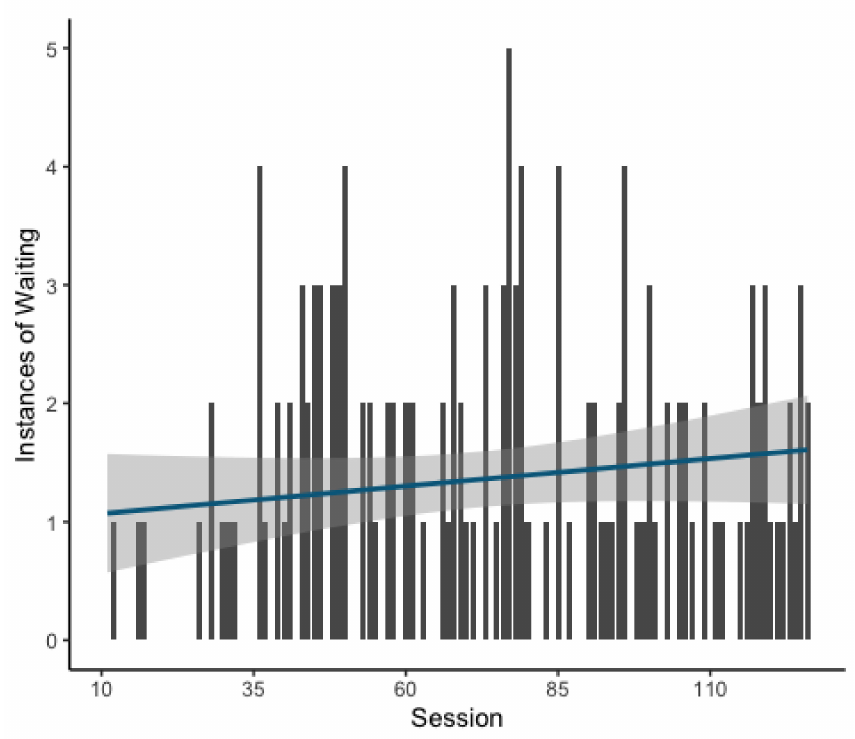
Figure 4. Bar graph showing instances of waiting per session with line of best fit overlaid. Greyed area indicates standard